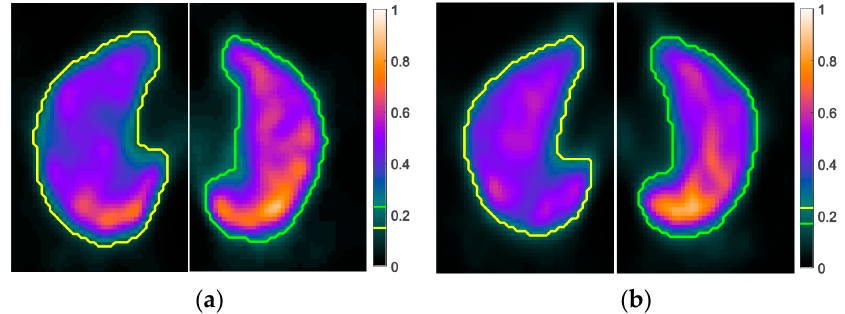
Figure 2. Segmented single-photon emission computer tomography (SPECT) images of a reference group patient. The contour of the segmentation is drawn in yellow (right lung) and green (left lung) in the images and the color bar: ( a ) ventilation, ( b ) perfusion.